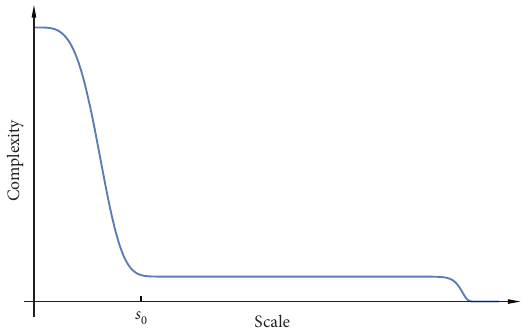
Figure 6: A complexity profile of a system with a separation of scales. A separation of scales implies that the behaviors occurring Figure 7: A normal distribution (thin-tailed) and a distribution below a certain scale ( s in the above figure) are at larger scales with a power-law decay (fat-tailed). The fat-tailed distribution may 0 mostly independent from one another, and that therefore, at these appear more stable, due to the lower probability of small-scale larger scales, only the average effects of the small-scale behaviors fluctuations and the fact that samples from the distribution may not are relevant. contain any extreme events. However, sooner or later, a fat-tailed distribution will produce an extreme event, while one could wait thousands of lifetimes of the universe before a normal distribution produces a similarly extreme event. Note that the axes of this graph are truncated; the illustrated fat-tailed distribution can, with small but nonnegligible probability (0.04%), produce events with a scale of one million or